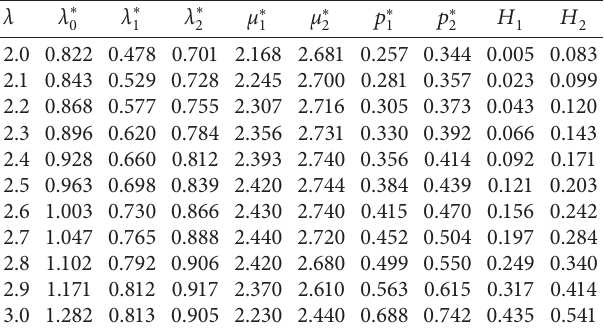
Table 3: Optimal parameters of services in